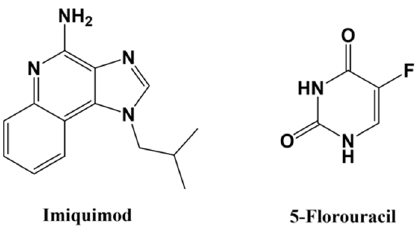
Figure 1. Chemical structures of imiquimod ( left ) and 5-florouracil ( right ). Imiquimod functions through an immunomodulatory response, and 5-florouracil inhibits DNA synthesis machinery. These treatments are effective topically against low-risk, superficial BCC.